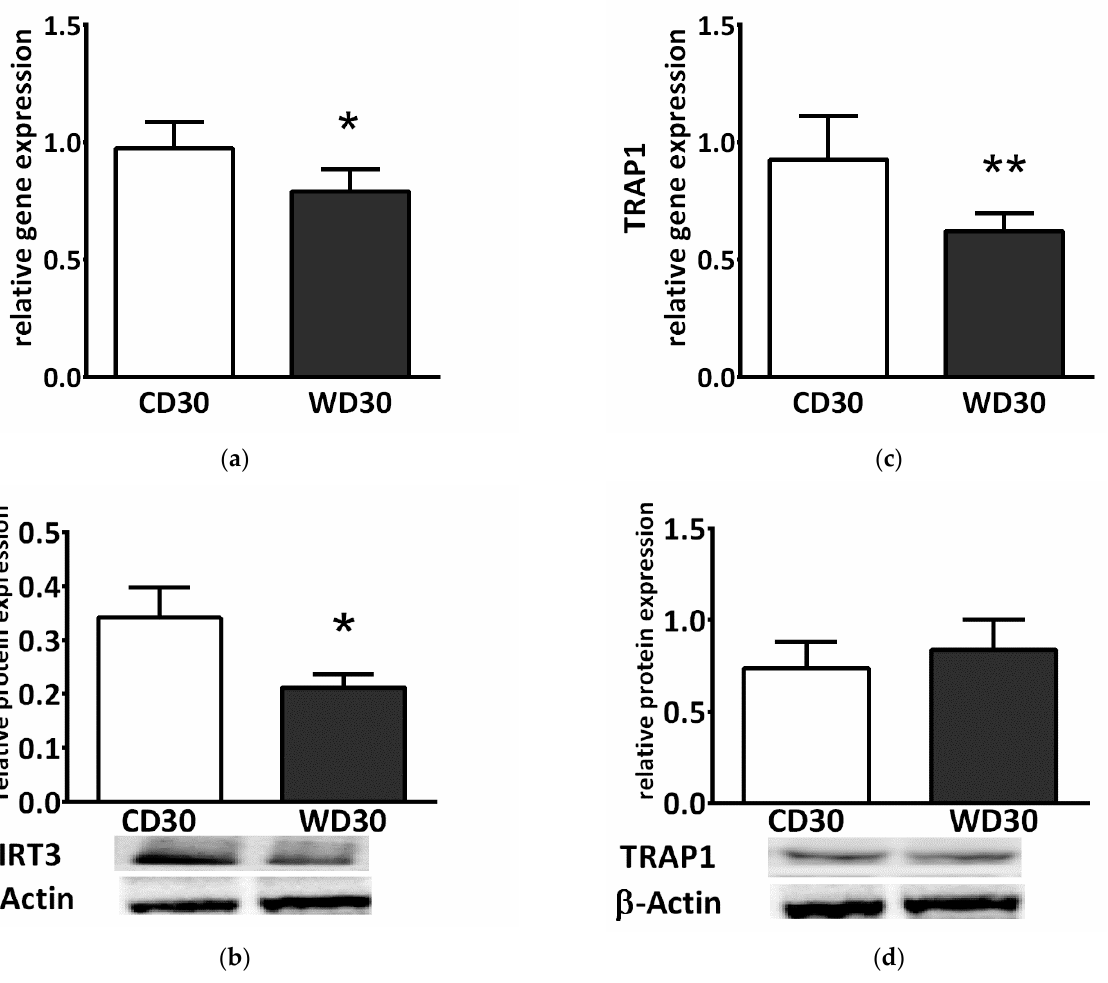
Figure 5. ( a ) Relative hepatic sirtuin 3 (SIRT3) gene and ( b ) protein expression. ( c ) Relative hepatic tumor necrosis factor receptor associated protein 1 (TRAP1) gene and ( d ) protein expression in mice fed a control diet (CD30) or a Western-style diet (WD30) for 30 weeks. Results are expressed as the means ± SD; * p < 0.05, ** p < 0.01 (n = 6 each group).